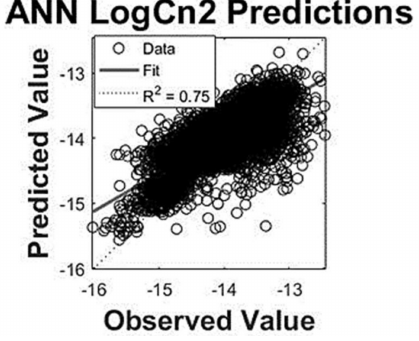
Figure 7. The ANN regression plot for the observed LogC 2 n values against the predicted values for the Monterey Bay dataset.